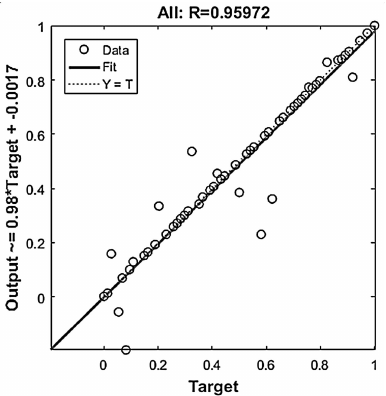
Figure 6. The comparison between the target (actual value of oxide scale thickness) and the output (predicted value oxide scale thickness).